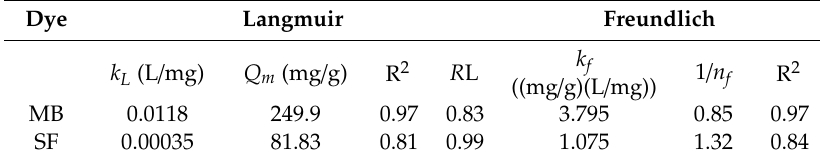
Table 5. Constant parameters of the Langmuir and Freundlich models for adsorption of MB and SF.